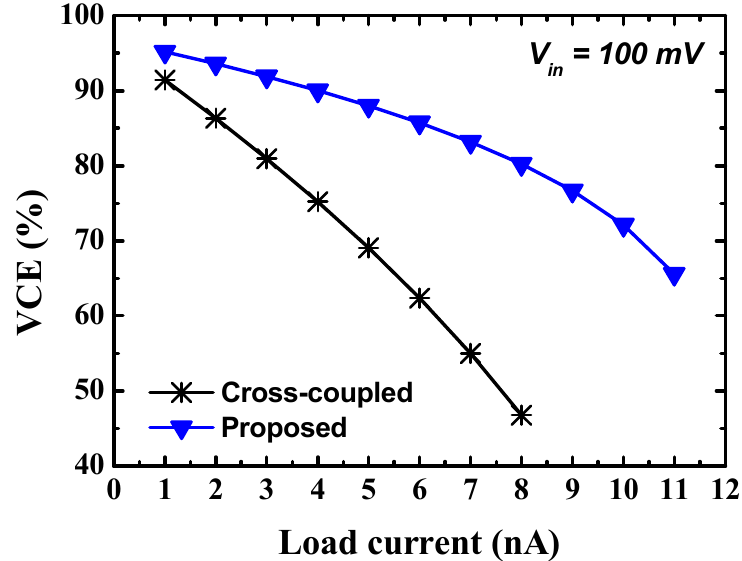
Figure 7. Simulated VCE according to the load current of the cross-coupled charge pump and proposed charge pump.